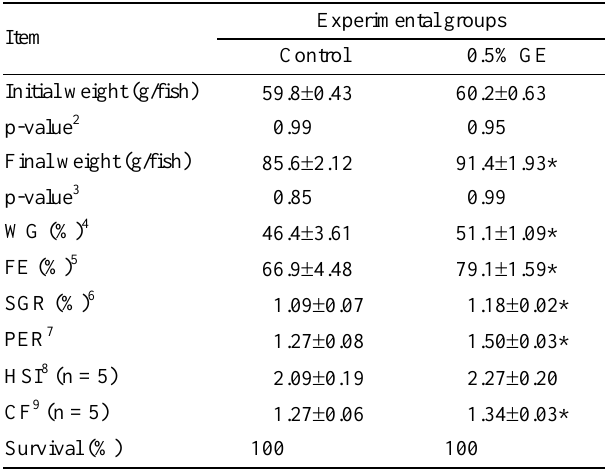
Table 2. Growth performance of juvenile sterlet sturgeon fed diets with or without garlic extracts (GE) for 5 wk 1